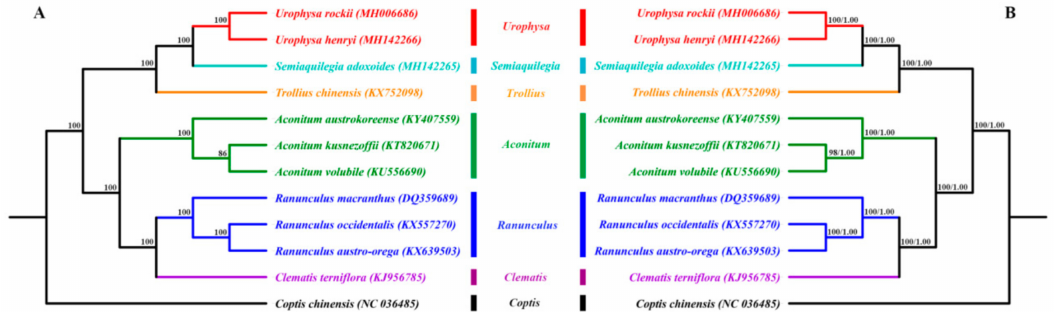
Figure 6. Phylogenetic relationship of Urophysa with related species based on 79 single-copy genes shared by all cp genomes. Tree constructed by ( A ) maximum likelihood (ML) with the bootstrap values of ML above the branches; ( B ) maximum parsimony (MP) and Bayesian inference (BI) with bootstrap values of MP and posterior probabilities of BI above the branches,